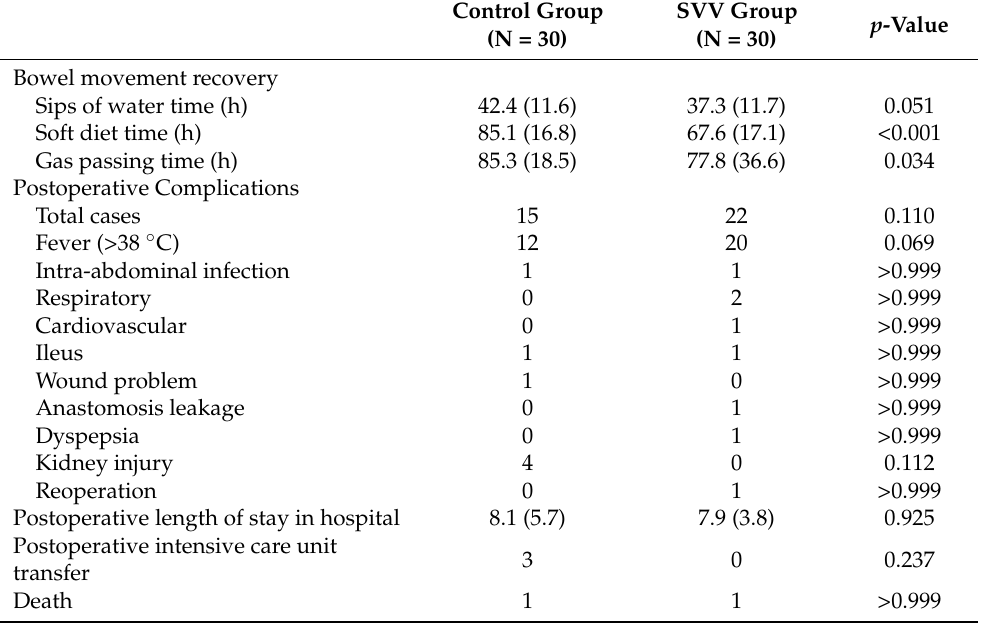
Table 4. Postoperative recovery